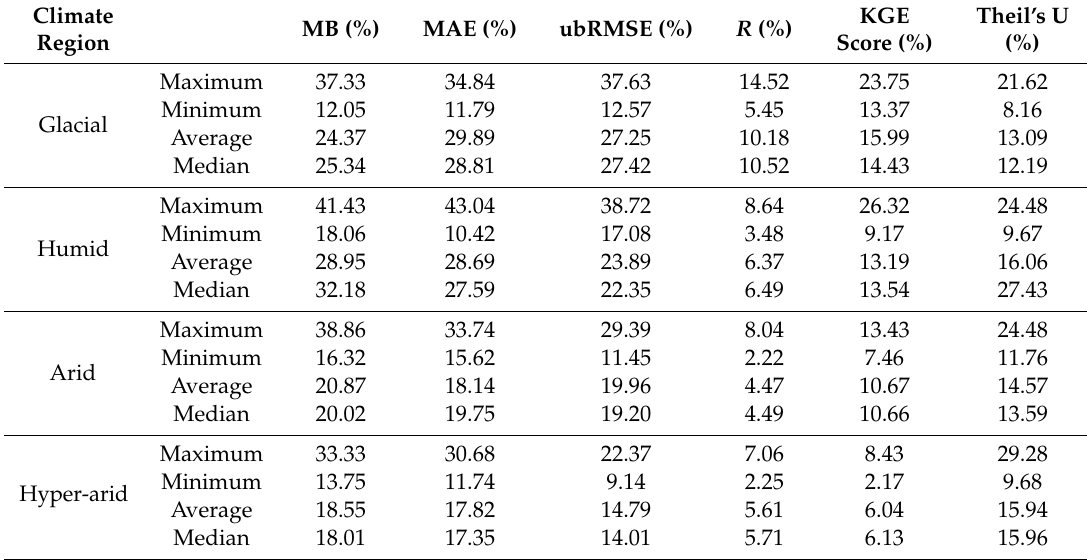
Table 7. Comparison of WALS-RBPD performance with blended precipitation dataset based on weighted average least squares (WALS-BPD) using skill score during a common period of 2007–2015.